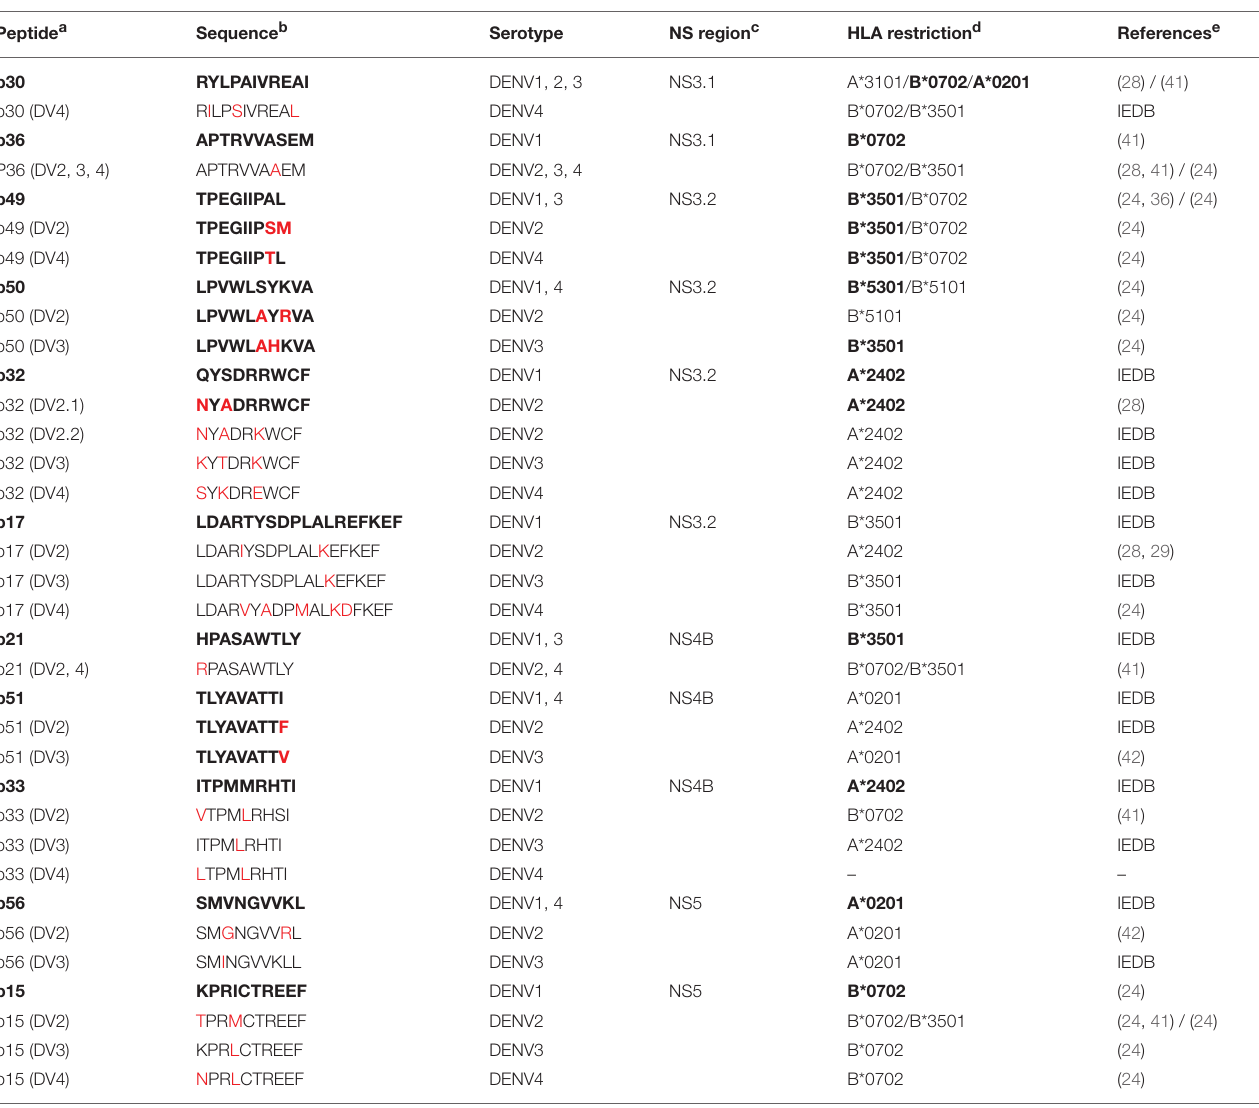
TABLE 1 | DENV Peptides and serotypes variants used in this study. Peptide